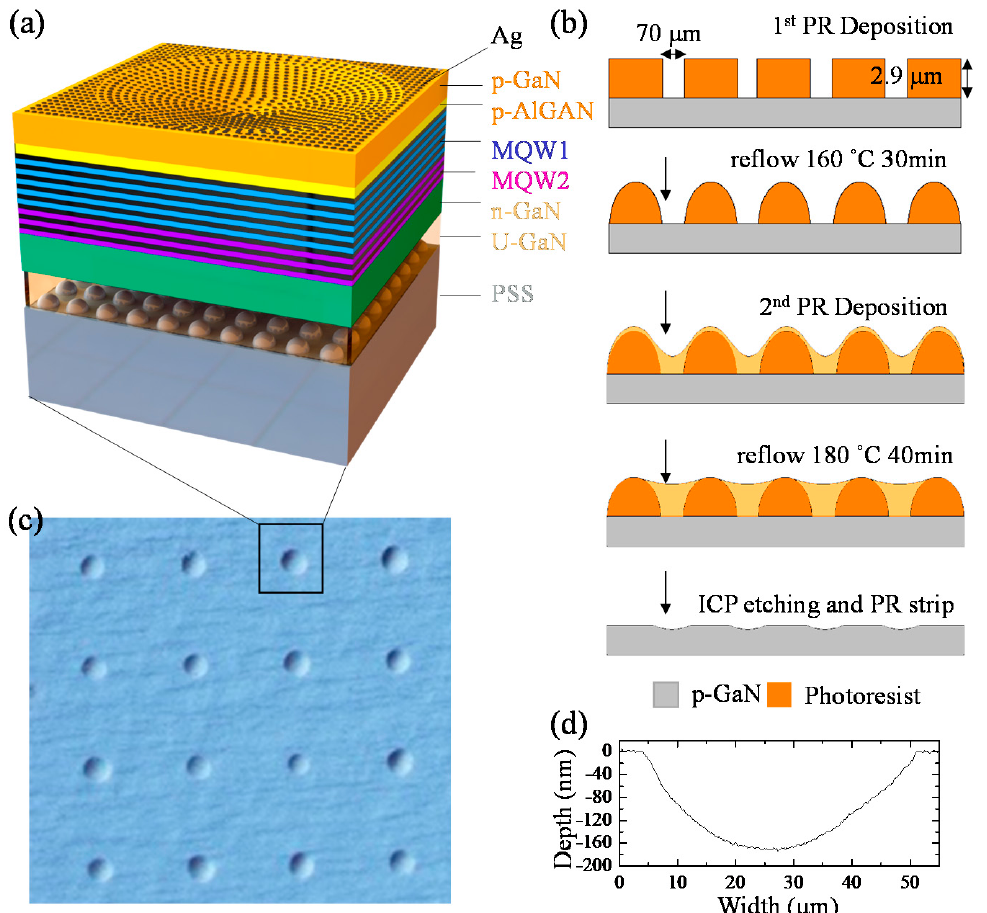
Figure 1. ( a ) LSP-LEDs structure diagram. ( b ) Fabrication process of microcave array structure. ( c ) Top-view optical image of the microcave array structure. ( d ) The depth profile of a single microcave. The plane-view secondary electron microscope (SEM) image of a microcave with Ag NPs is shown in Figure 2a. The diameter distribution of the Ag NPs is shown in the inset of Figure 2a. The median − 2 diameter of NPs is 110 nm and the density of the NPs is calculated as 4.46 × 10 8 cm